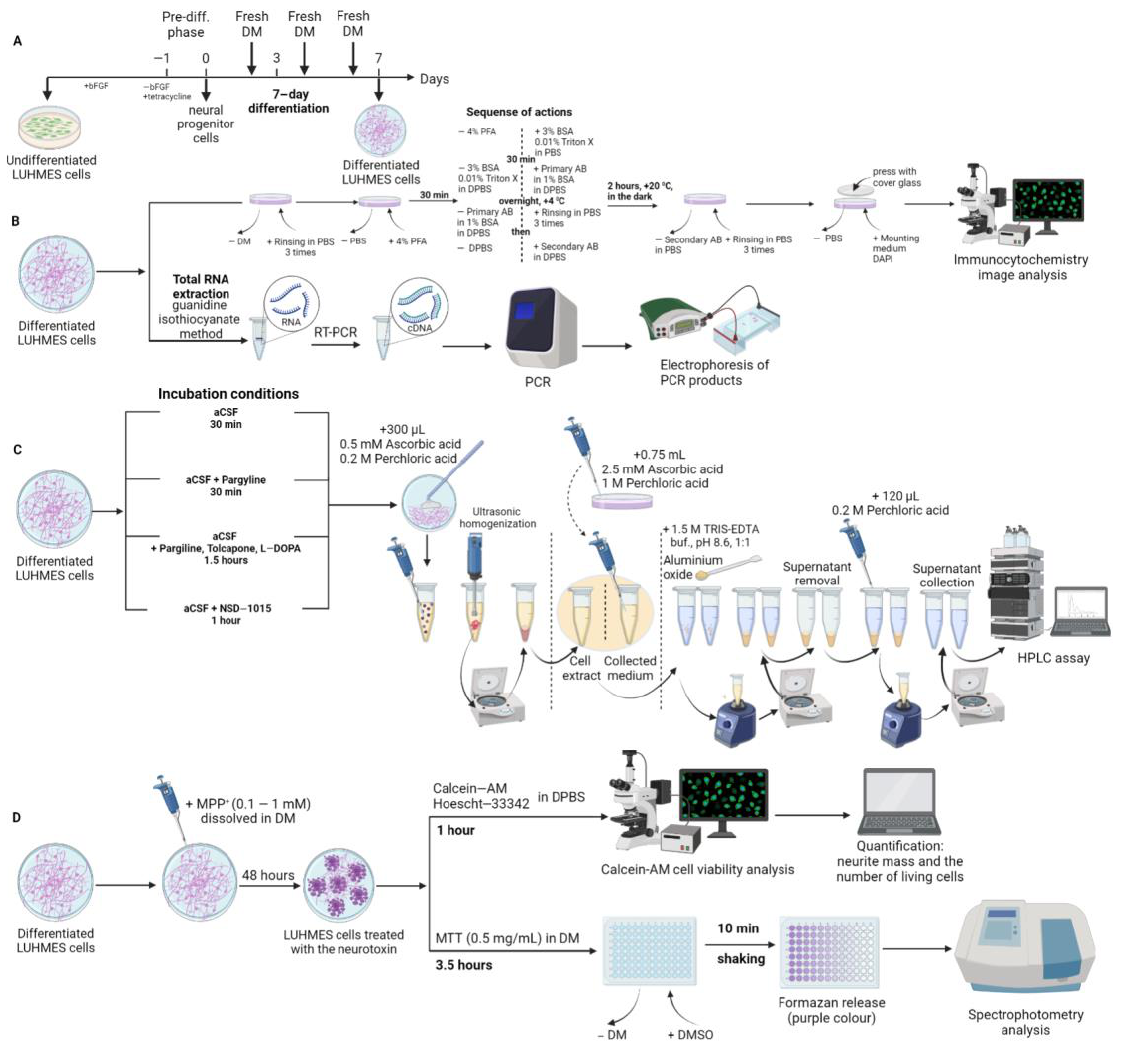
Figure 10. Scheme of LUHMES cell differentiation ( A ), sample preparation and methods used ( B –